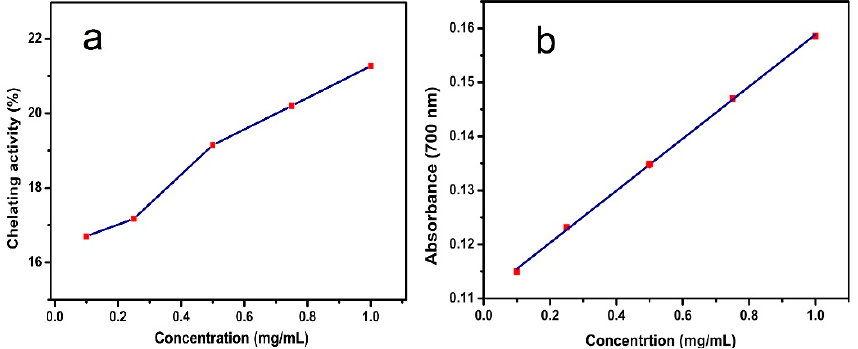
Figure 7. ( a ) The chelating ability on Fe 2+ of ginger extract; ( b ) the reduction capability of Fe 3+ of ginger extract.